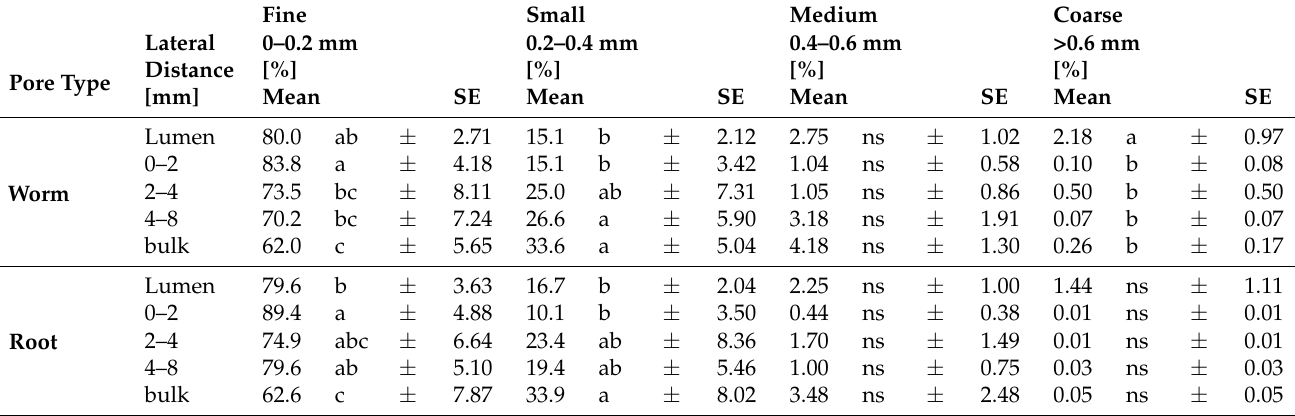
Table 2. Proportion of root length [%] of spring oilseed rape categorized in diameter classes [mm]. Mean and SE of lateral distances. Means not sharing a common letter indicate significant differences (Tukey-HSD, α = 0.05); ns = not significant. Fine Small Medium Coarse Lateral 0 – 0.2 mm